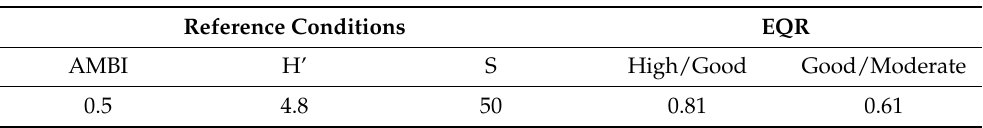
Table 2. The reference conditions and the type specific EQR. Key: AZTI’s Marine Biotic Index (AMBI); Shannon–Wiener diversity index (H’); N ◦ of species